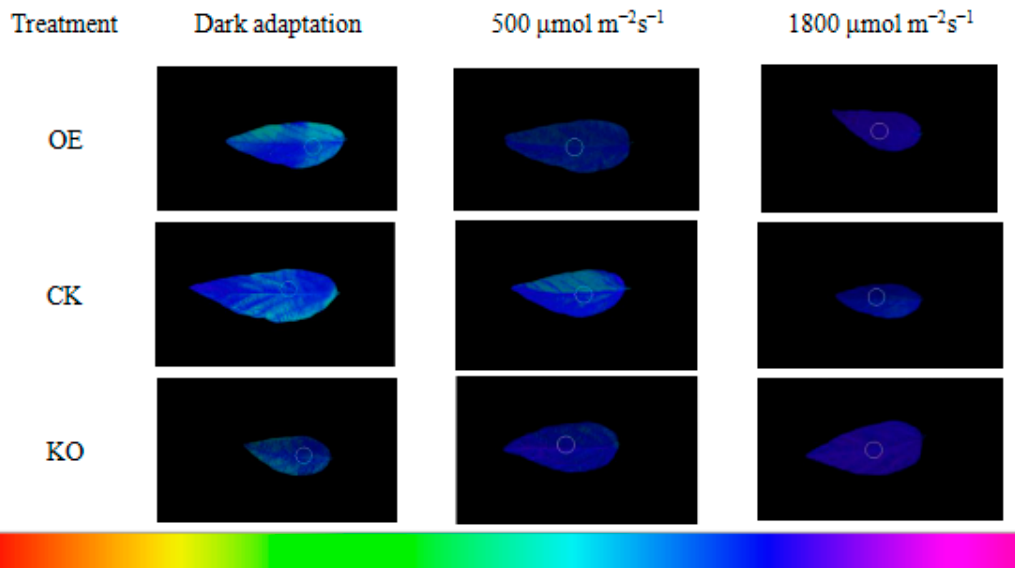
Figure 10. Effects of strong light stress on Chl fluorescence images of WT and the T 3 generation of GmRIQ2 - like- OE and -KO transgenic soybean seedlings.